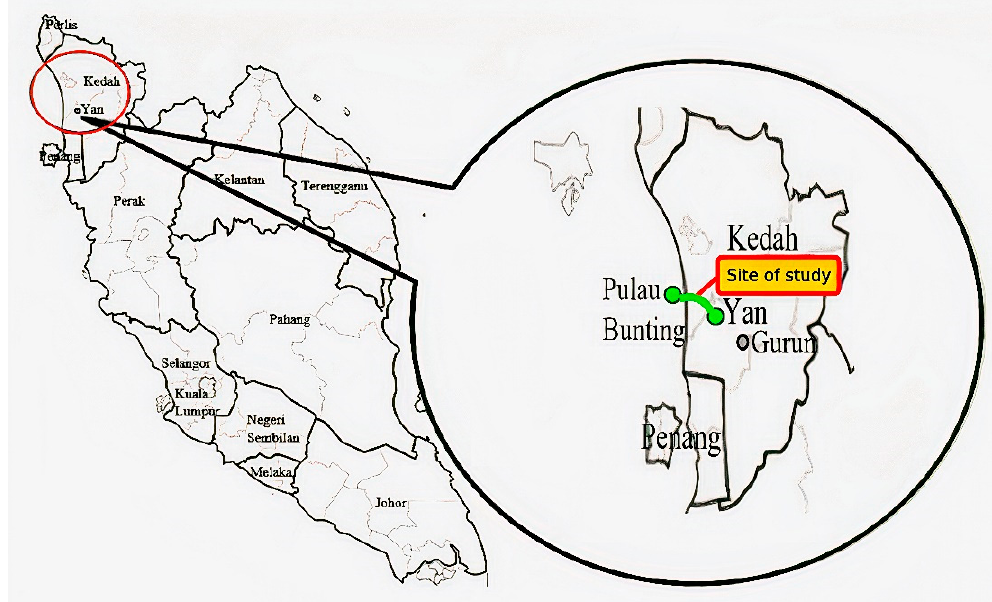
Figure 1. Location of study.